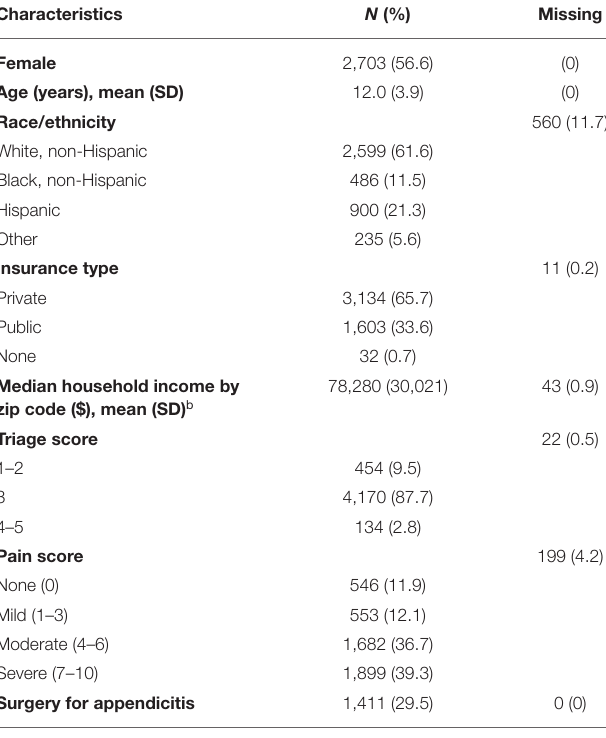
TABLE 3 | Factors associated with the administration of any analgesic treatment and opioid analgesia for children visiting the emergency department with a limb fracture.